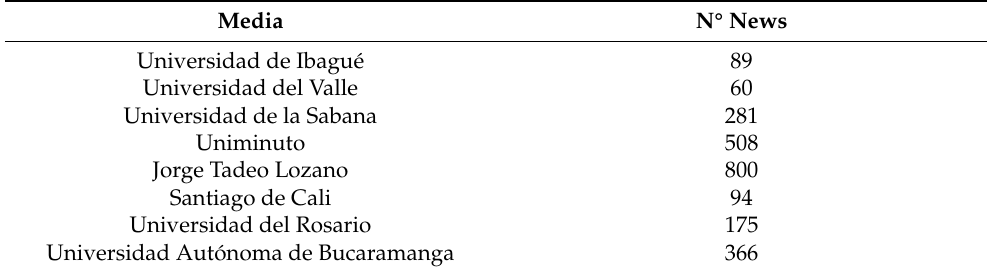
Table 2. Number of news per media in the Colombian conflict